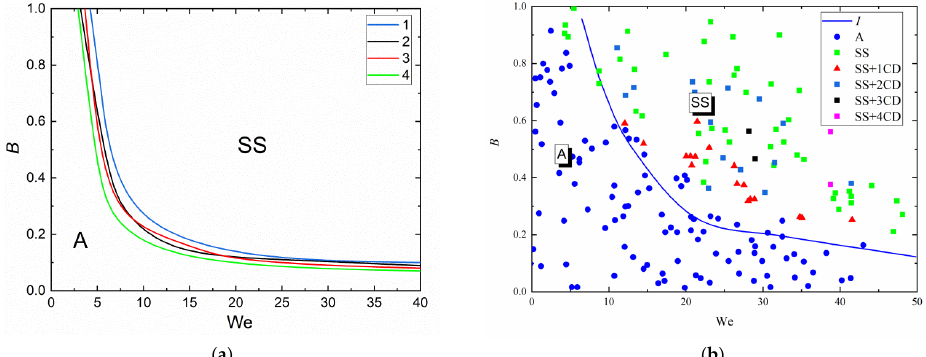
Figure 9. Interaction regime maps ( a ) for distilled water droplets colliding with carbonaceous particles of coals of different ranks at Δ = 1, R d = R p = 1.1 – 1.2 mm, ( b ) water droplets colliding with solid particles (approx. 3 mm in diameter) [35]: 1 — filter cake of coking coal; 2 — brown coal; 3 — coking coal; 4 — anthracite. A — agglomeration; SS — stretching separation; CD — child droplets.